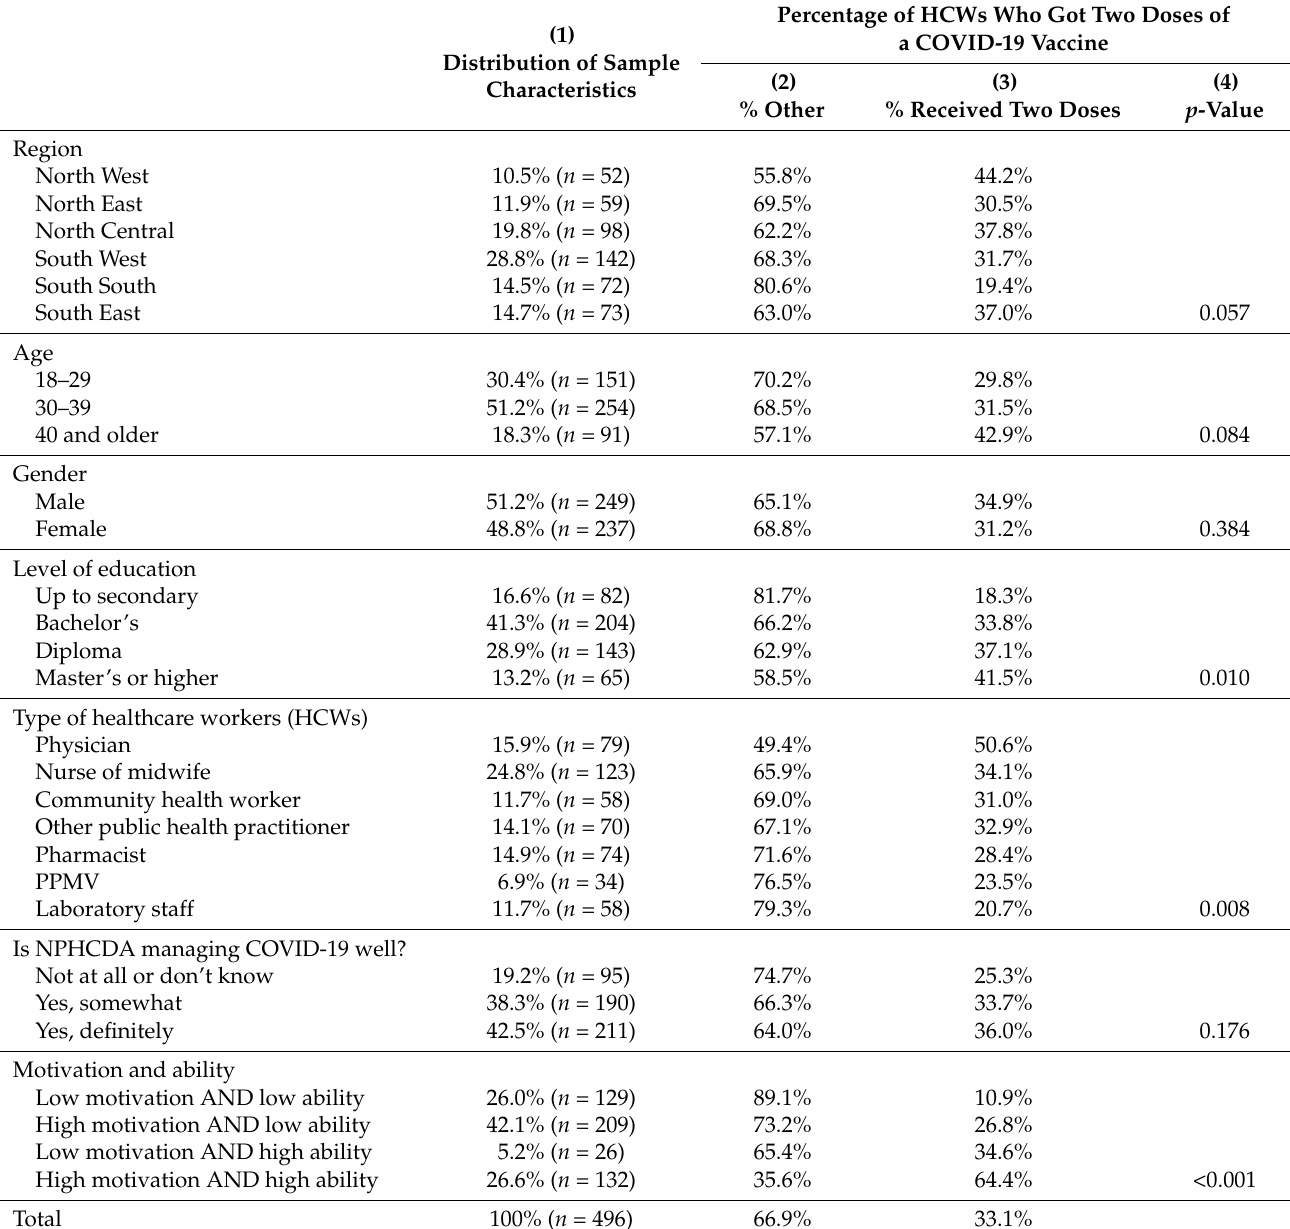
Table 1. Distribution of sample characteristics and % of HCWs who got two doses of a COVID-19 vaccine.